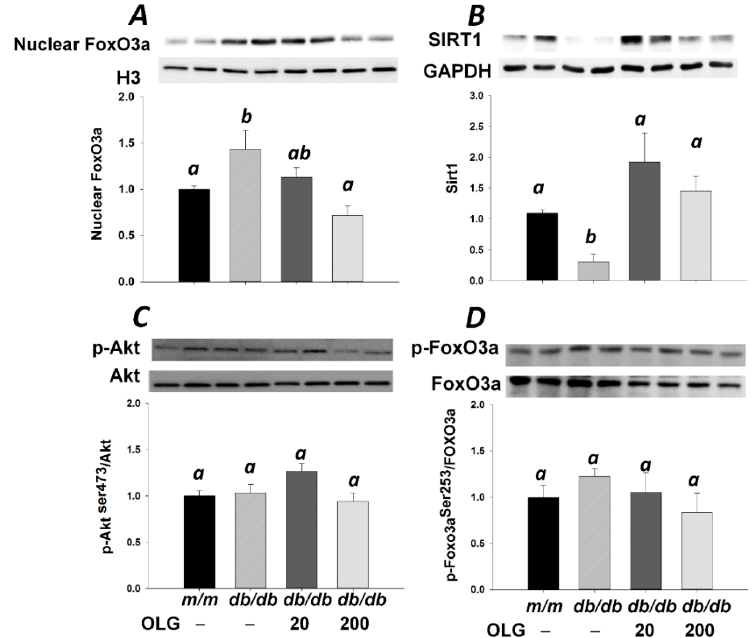
Figure 3. Representative blots of nuclear FoxO3a ( A ), SIRT1 ( B ), phospho-Akt (Thr473), Akt ( C ), phospho-FoxO3a (Ser253), and total FoxO3a ( D ) in m/m and db/db mice with or without oligonol (OLG) supplement are shown ( n = 5–6/group). Significance ( p < 0.05) among groups is denoted by different letters.